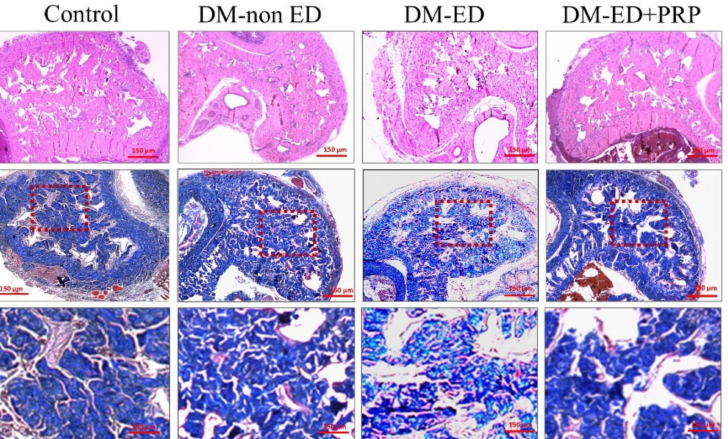
Figure 6. Micrograph showing the hematoxylin and eosin staining and Masson’s trichrome staining of the corpus cavernosum (40 × magnification). DM-non ED, streptozotocin (STZ)-induced diabetes mellitus (DM) without erectile dysfunction (ED); DM-ED, STZ-induced DM with ED and treated with saline; DM-ED + PRP, STZ-induced DM with ED and treated with platelet-rich-plasma. Red colour demarcated area magnified into 200 ×